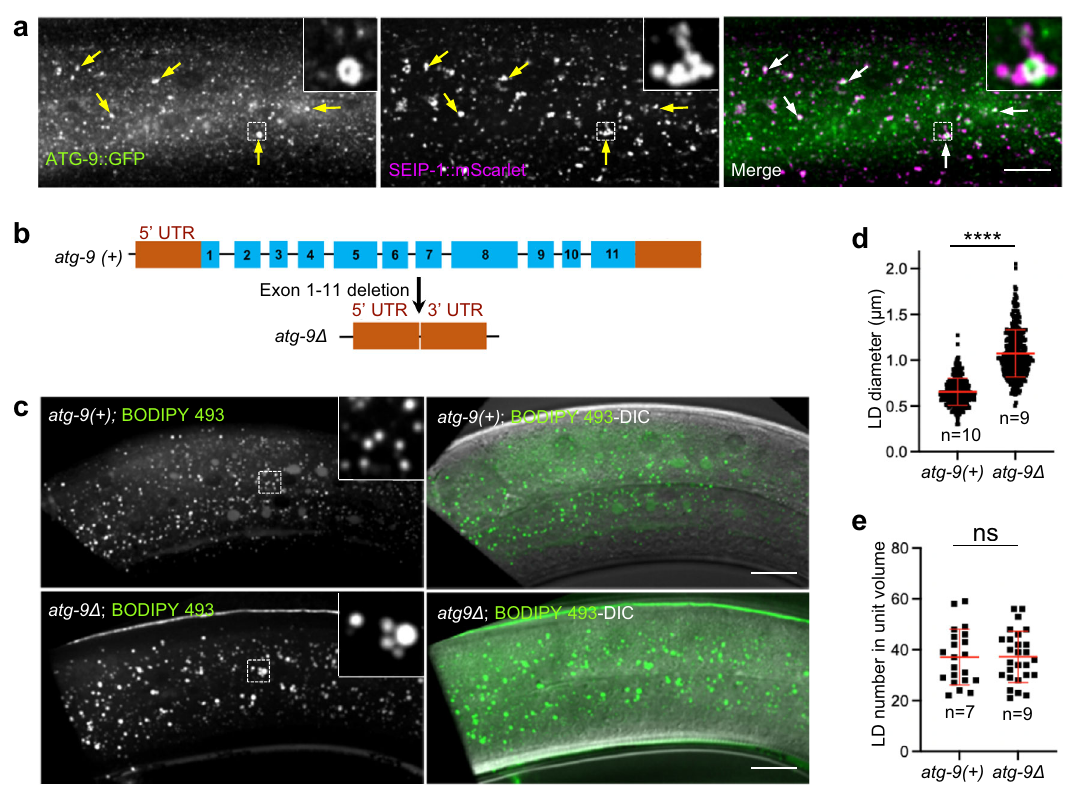
Fig. 9 Deletion of atg-9 causes enlargement of LDs in C. elegans hypodermal cells. a Fluorescence microscopy imaging of hypodermal tissue from WT C. elegans expressing endogenously tagged ATG-9::GFP (green) and SEIP-1::mScarlet (magenta). Scale bar: 20 μ m. Arrows indicate puncta where ATG-9::GFP and SEIP-1::mScarlet co-localize. Insets are 4x magni fi ed views of the boxed areas. Results are representative from three independent experiments. b Schematic representation of the genomic structure of the WT atg-9( + ) and mutant atg-9 Δ alleles. c Fluorescence microscopy and differential interference contrast (DIC) imaging of hypodermal tissue from WT ( atg-9( + ) ) and atg-9 Δ animals stained with BODIPY 493. Scale bars: 20 μ m. Insets are 4x magni fi ed views of the boxed areas. Results are representative from three independent experiments. d , e Quanti fi cation of LD diameter and number in WT ( atg-9( + ) ) and atg-9 Δ hypodermal tissue in the indicated number (n) of animals. d Graph showing the individual values and the mean ± SD of LD diameter. Approximately 30 LDs were measured per animal. Statistical signi fi cance was determined using the unpaired two-tailed Student ’ s t -test (**** p < 0.0001). e Graph showing the individual values and the mean ± SD of LD number, quanti fi ed in a unit volume ( L 18 μ m x W 18 μ m x H 10 μ m) with three independent units measured per